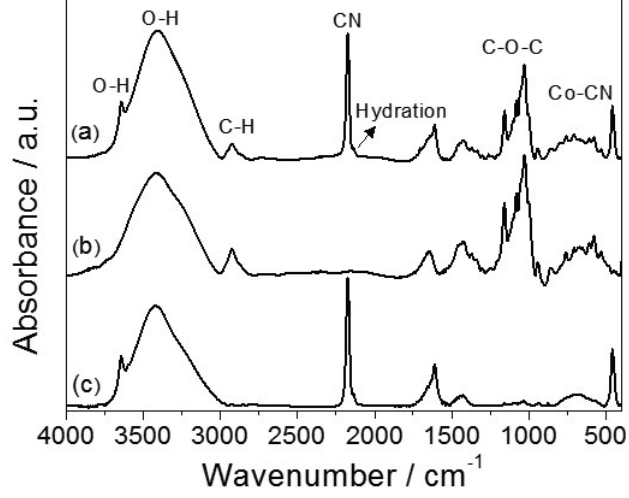
Figure 3. FTIR spectra for (a) PBA-CD (b) CD polymer and (c)